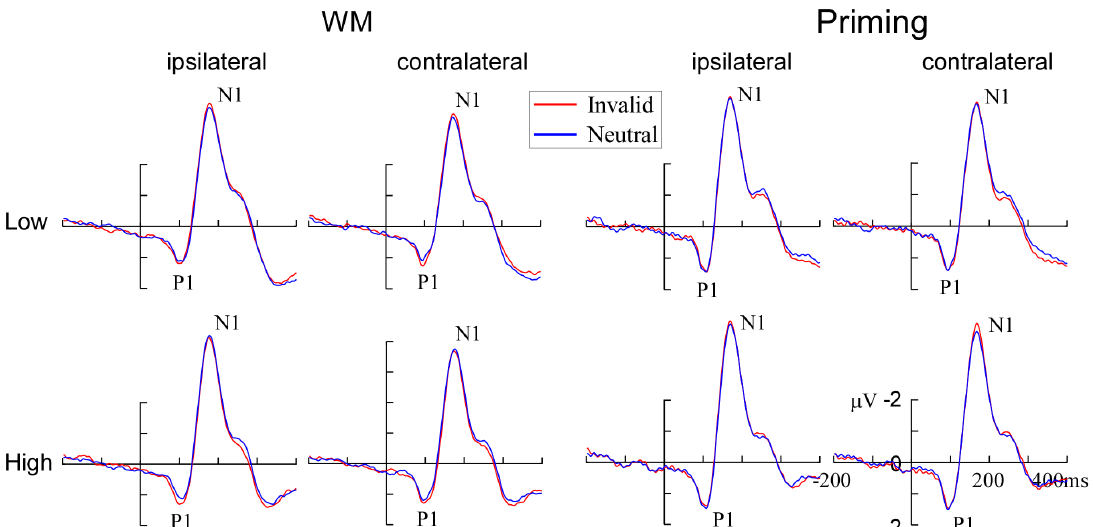
Fig 3. The validity effects on the P1 and N1 component under the low perceptual load (upper panels) and the high perceptual load (lower panels) conditions when the cue was held in WM (left panels) and when it was merely identified (right panels). Data were also averaged across memory- matching stimuli at ipsilateral vs. contralateral electrode sites. The left occipito-parietal electrodes include O1, PO3 and PO7 and the right occipito-parietal electrodes include O2, PO4 and